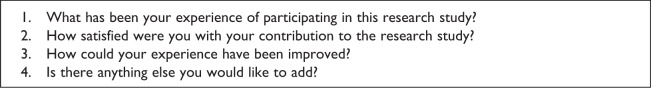
Semi-structured topic guide used for both groups.